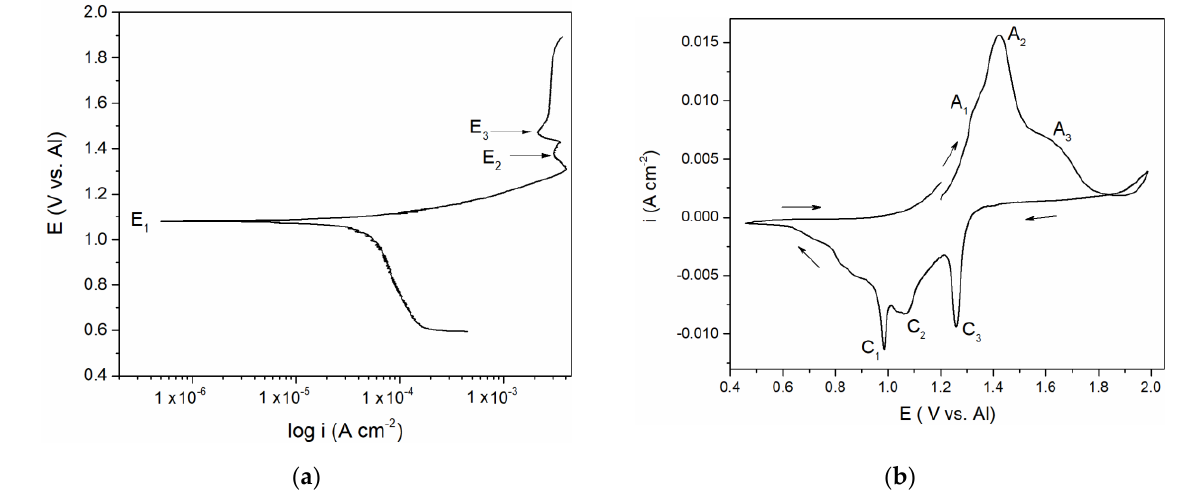
Figure 1. ( a ) Potentiodynamic polarization curve of vanadium working electrode (WE) in equimolar melt AlCl 3 + NaCl, T = 200 °C, potential range: E I = 0.600 V → E AF = 1.900 V vs. Al; v = 1 mVs −1 ; ( b ) Cyclic voltammogram of vanadium WE in equimolar AlCl 3 + NaCl melt, T = 200 °C, potential change from E I = 1.200 V vs. Al to E AF = 2.000 V vs. Al, then to E CF = 0.500 V vs. Al and finally back to E I = 1.200 V vs. Al, v = 20 mVs −1 .